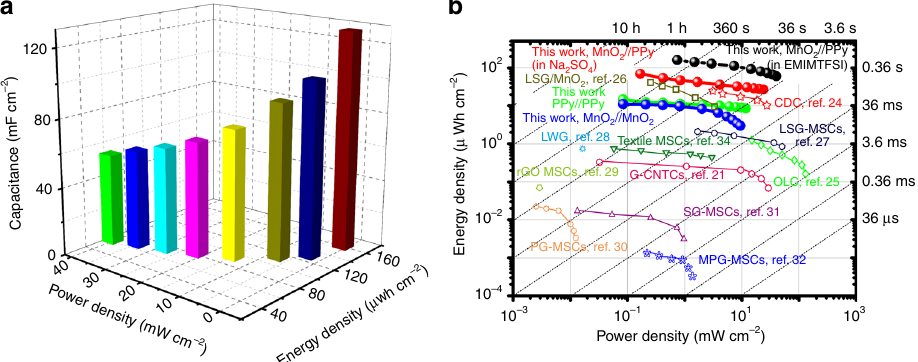
Fig. 6 Energy performance of HAN@SnO 2 @MnO 2 //HAN@SnO 2 @PPy asymmetric MSCs. a Areal performance metrics of HAN@SnO 2 @MnO 2 // HAN@SnO 2 @PPy asymmetric MSCs with EMIM-TFSI ionic liquid electrolyte. b Ragone plots of MSCs with HAN-based nanoelectrodes compared with some reported MSCs 21,24 – 34